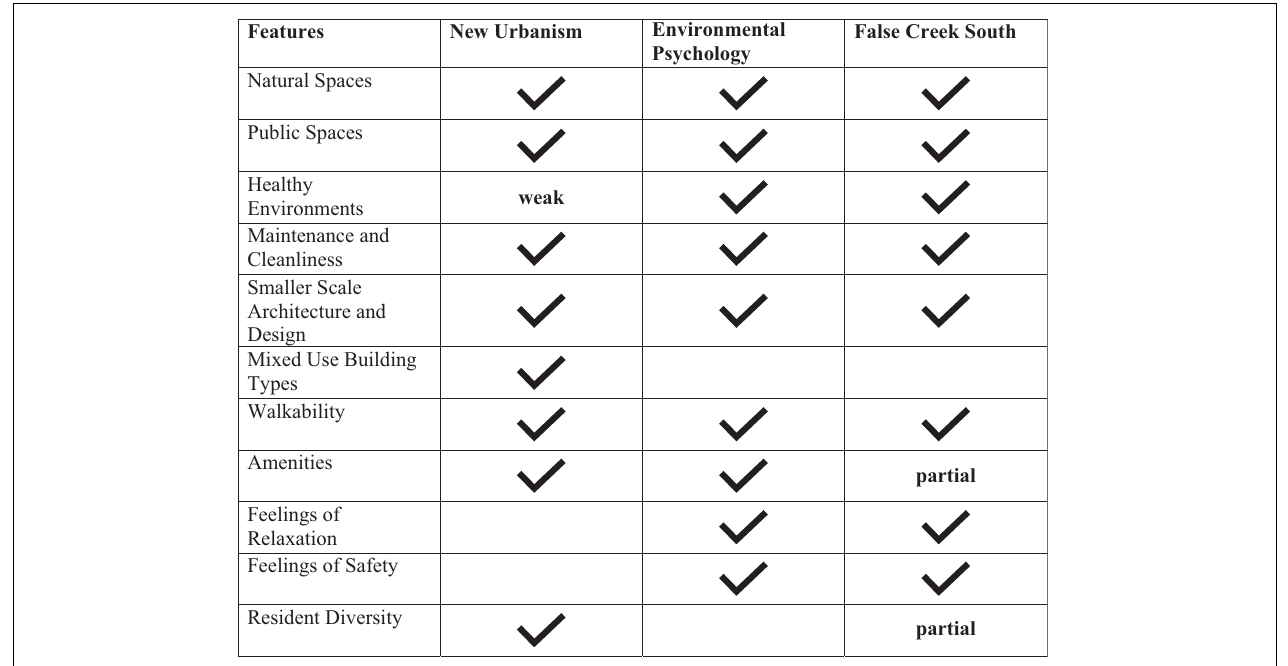
FIGURE 2 | A comparison of desired attributes in new urbanism and environmental psychology and their presence in False Creek South.